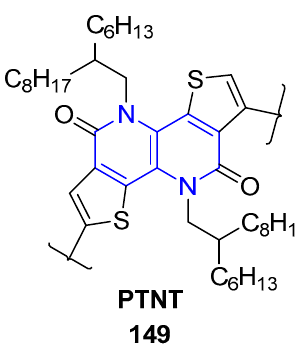
Figure 22. Fused 1,5-naphthyridine with OLED properties.